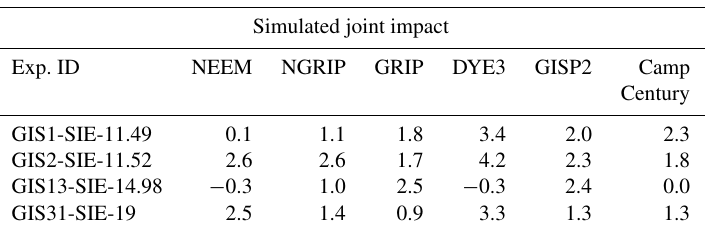
Table B2. Simulated δ 18 O p anomalies compared to 125ka control on six Greenland deep ice cores: NEEM, NGRIP, GRIP, DYE3, GISP2 and Camp Century. δ 18 O p anomalies due to the joint impact of GIS shape changes and sea ice changes are